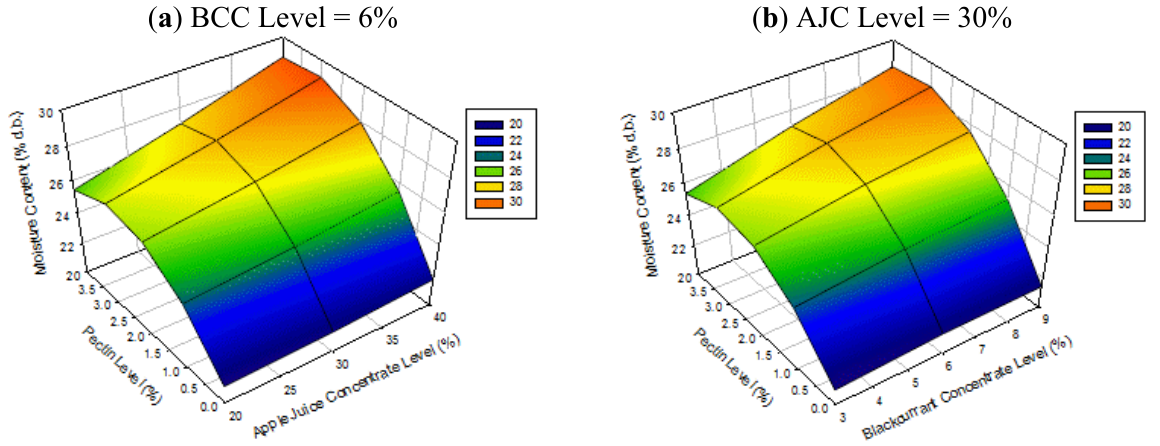
Figure 1. Surface plots for moisture content of apple-blackcurrant fruit leather as affected by apple juice concentrate (AJC) and pectin levels ( a ) and blackcurrant concentrate (BCC) and pectin levels ( b ) with the third factor set at the middle level (legend shows the range of values on the response surface).